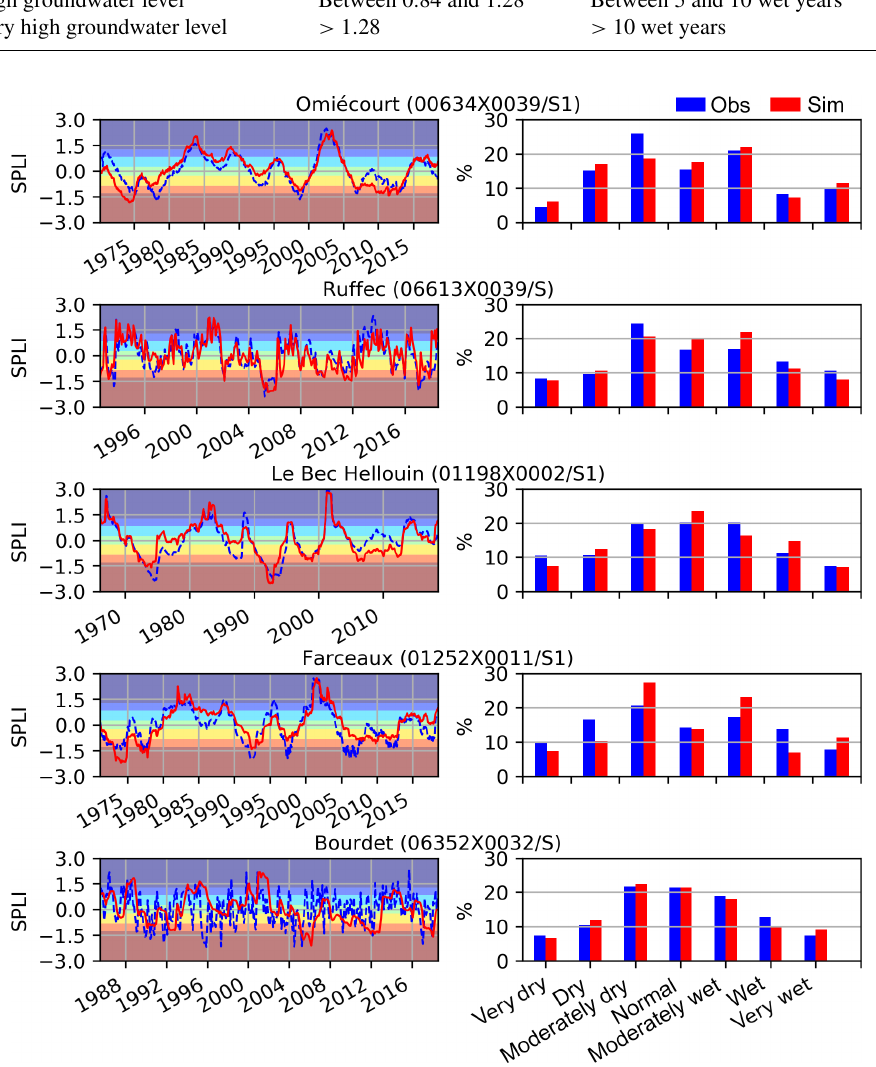
Figure 10. In the left panels are the monthly observed (dotted blue) and simulated (red) SPLI indicator variations for the five piezometers encircled in green in Fig. 3. Font colours correspond to the classes of Table 3 from the driest (red) to the wettest (blue) intervals. In the right panels are histograms in percentage of the SPLI values distributed against the classes of Table